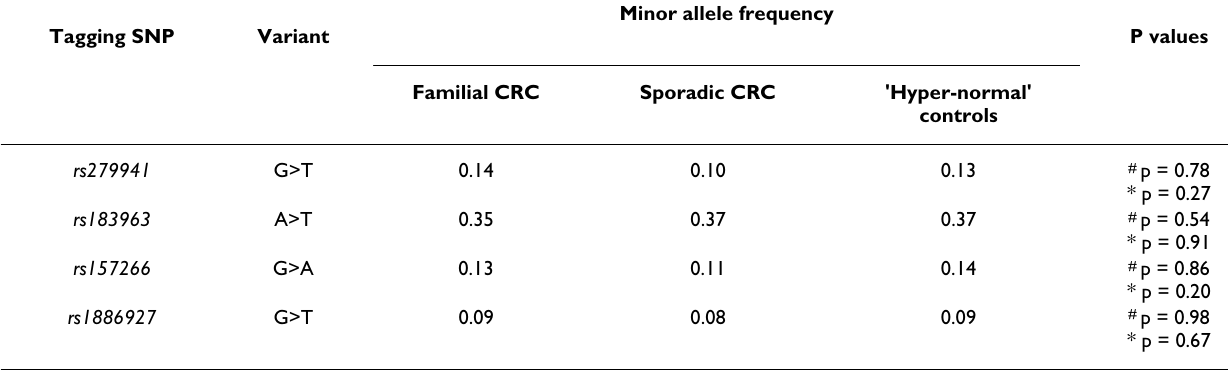
Table 2: SLC10A2 tagging SNPs and minor allele frequencies Tagging SNP